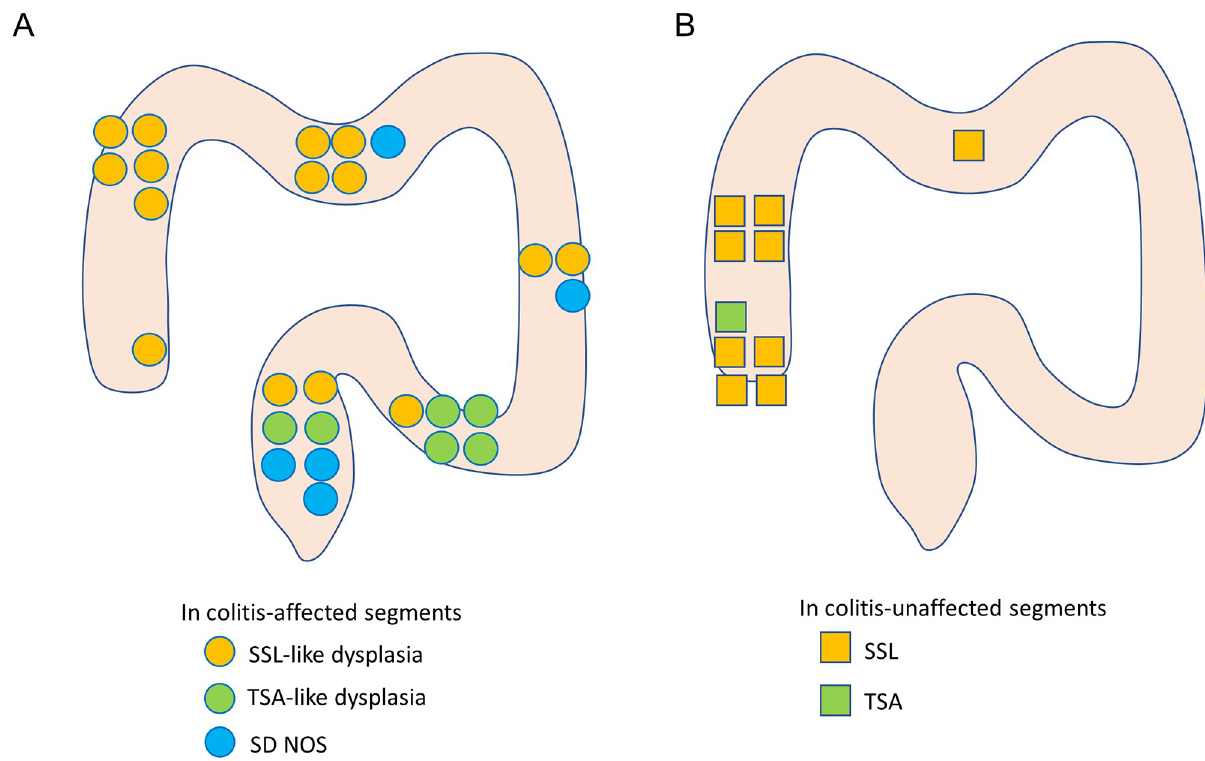
Fig 3. Distribution of serrated polyps in patients with UC. (A) Among serrated polyps in colitis-affected segments, 15 lesions were SSL-like dysplasia, 6 were TSA-like dysplasia, and 5 were SD NOS. (B) Among serrated polyps in colitis-unaffected segments, nine lesions were SSLs and one was a TSA. SD NOS, serrated dysplasia not otherwise specified; SSL, sessile serrated lesion; TSA, traditional serrated adenoma.